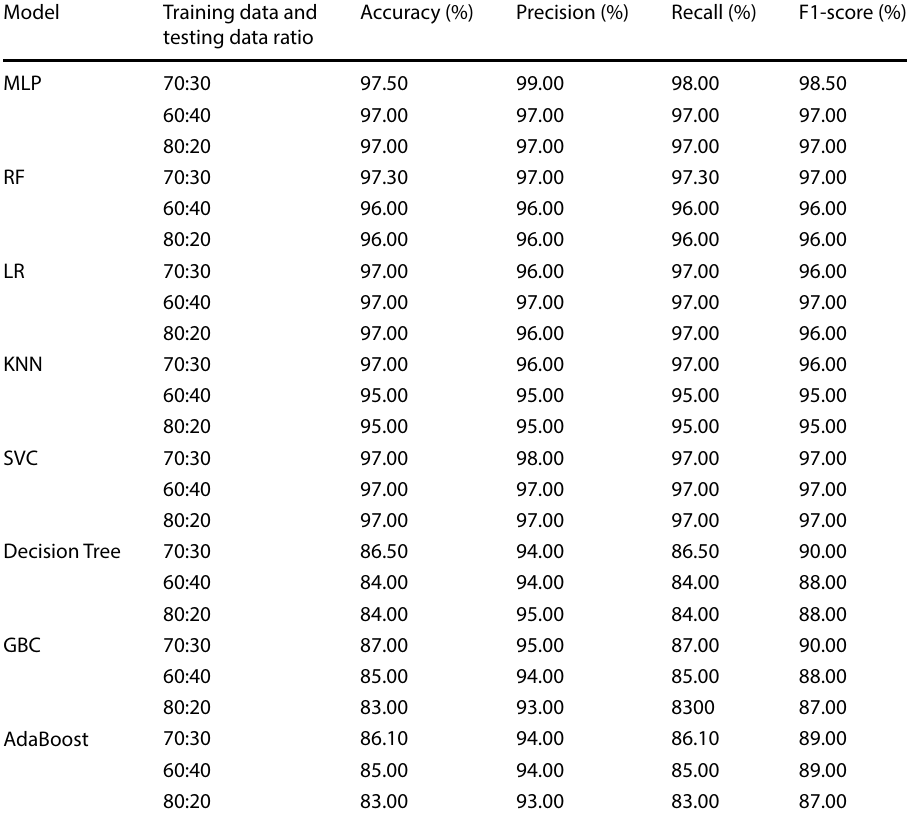
Table 4 Performance comparison of different classification algorithms on top 20 features